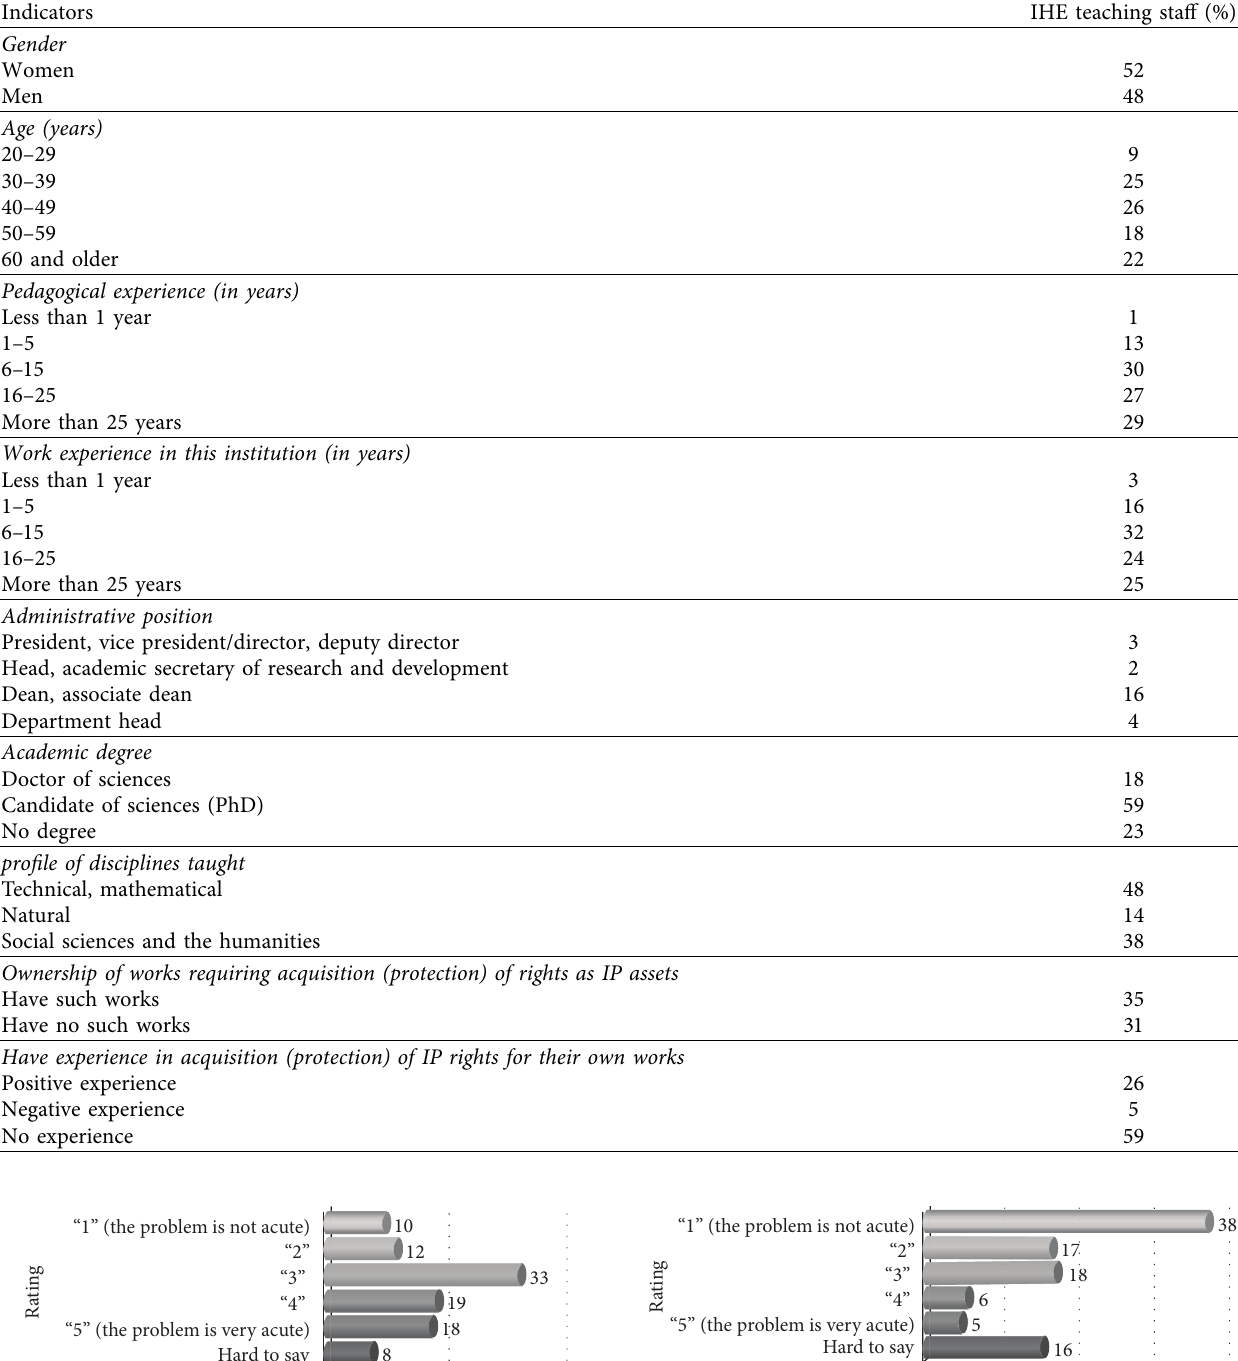
Table 1: Main sociodemographic indicators of research object.